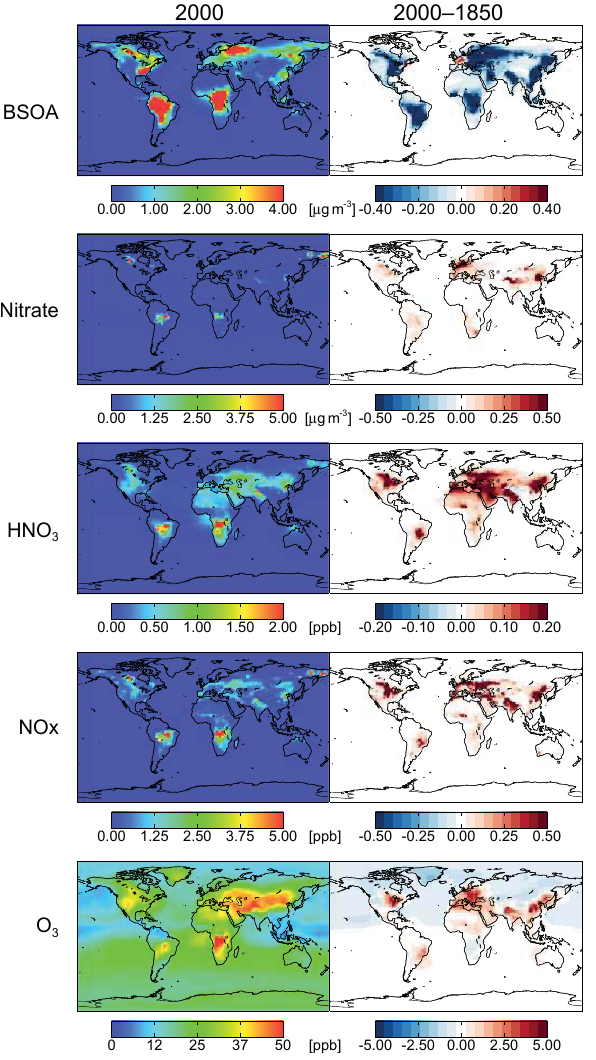
Figure 10. Boreal wintertime (December–February) mean simu- lated surface concentrations of biogenic SOA (BSOA), aerosol ni- trate, nitric acid (HNO 3 ) , nitrogen oxides (NO x ), and ozone. Con- centrations for present day (2000) shown on the left; the change due to historical land use change is shown on the right. All sim- ulations performed with preindustrial (1850) anthropogenic emis- sions; shown here are the differences between simulations 6 and 4 (see Tables 1 and 2). Shown with same colour bars as Fig. 8 for